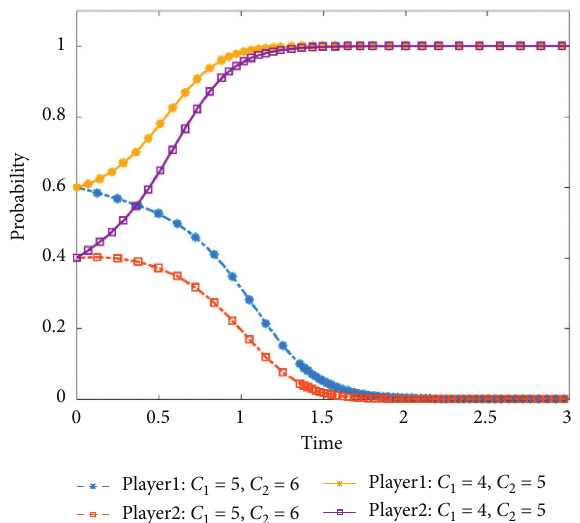
Figure 11: Evolutionary game phase diagram of the system (when C and C decrease). 1 2 1